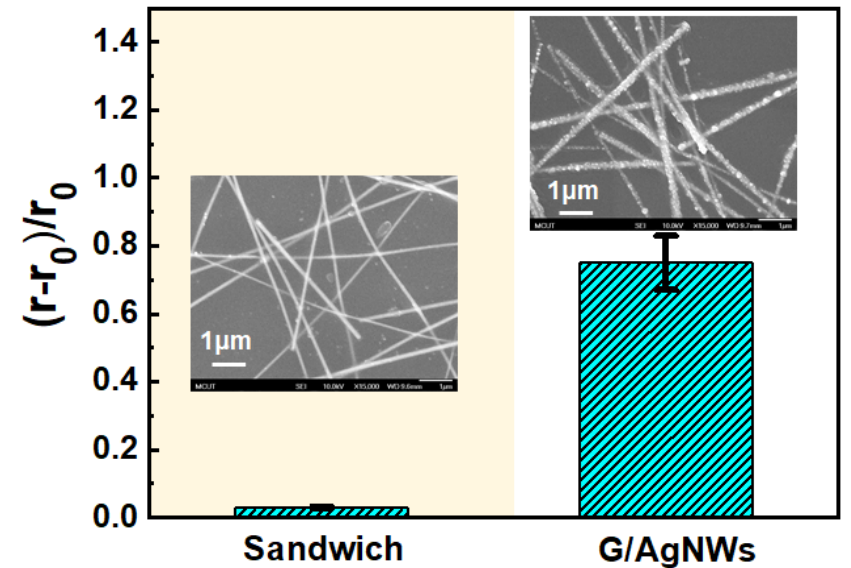
Figure 4. Resistance variation of the sandwich and AgNWs/G structures after exposing to the ambient for 18 h. Insets show the SEM images after exposure.